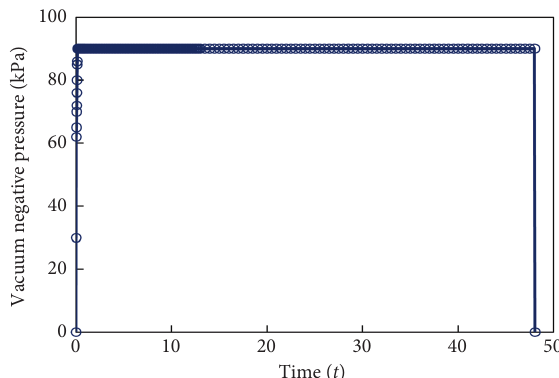
Figure 7: The vacuum negative pressure load of sludge dewatering without straw.